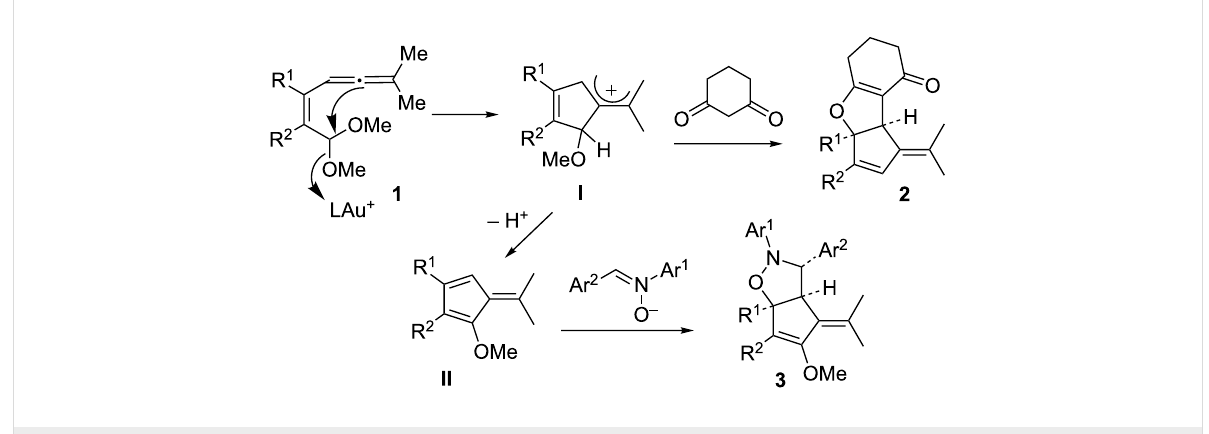
Scheme 1: Reported cascade reactions on allenyl acetals.